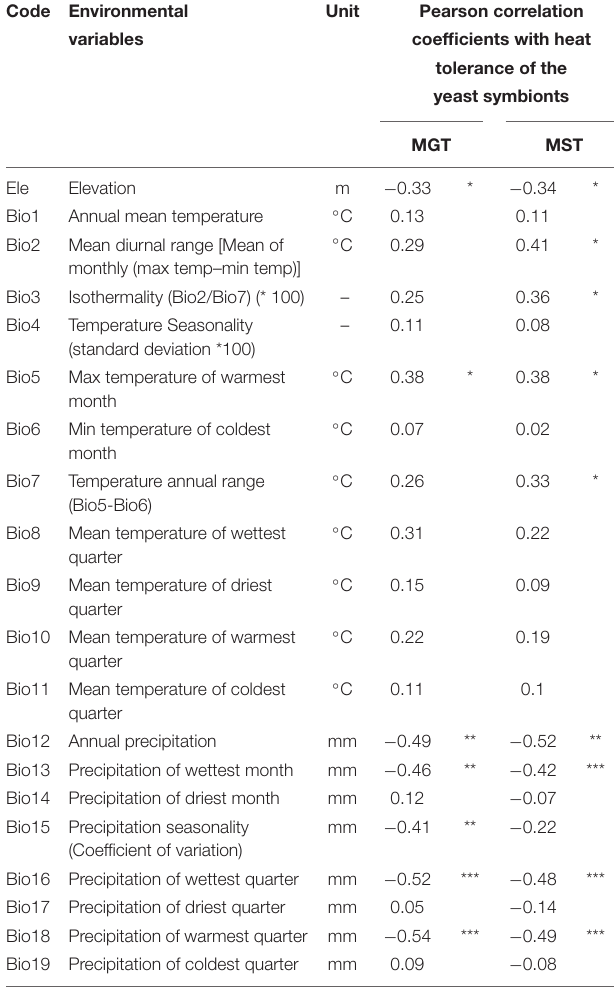
TABLE 2 | List of environmental variables examined in this study and Pearson correlation coefficients with the maximum growth temperature (MGT) and maximum survival temperature